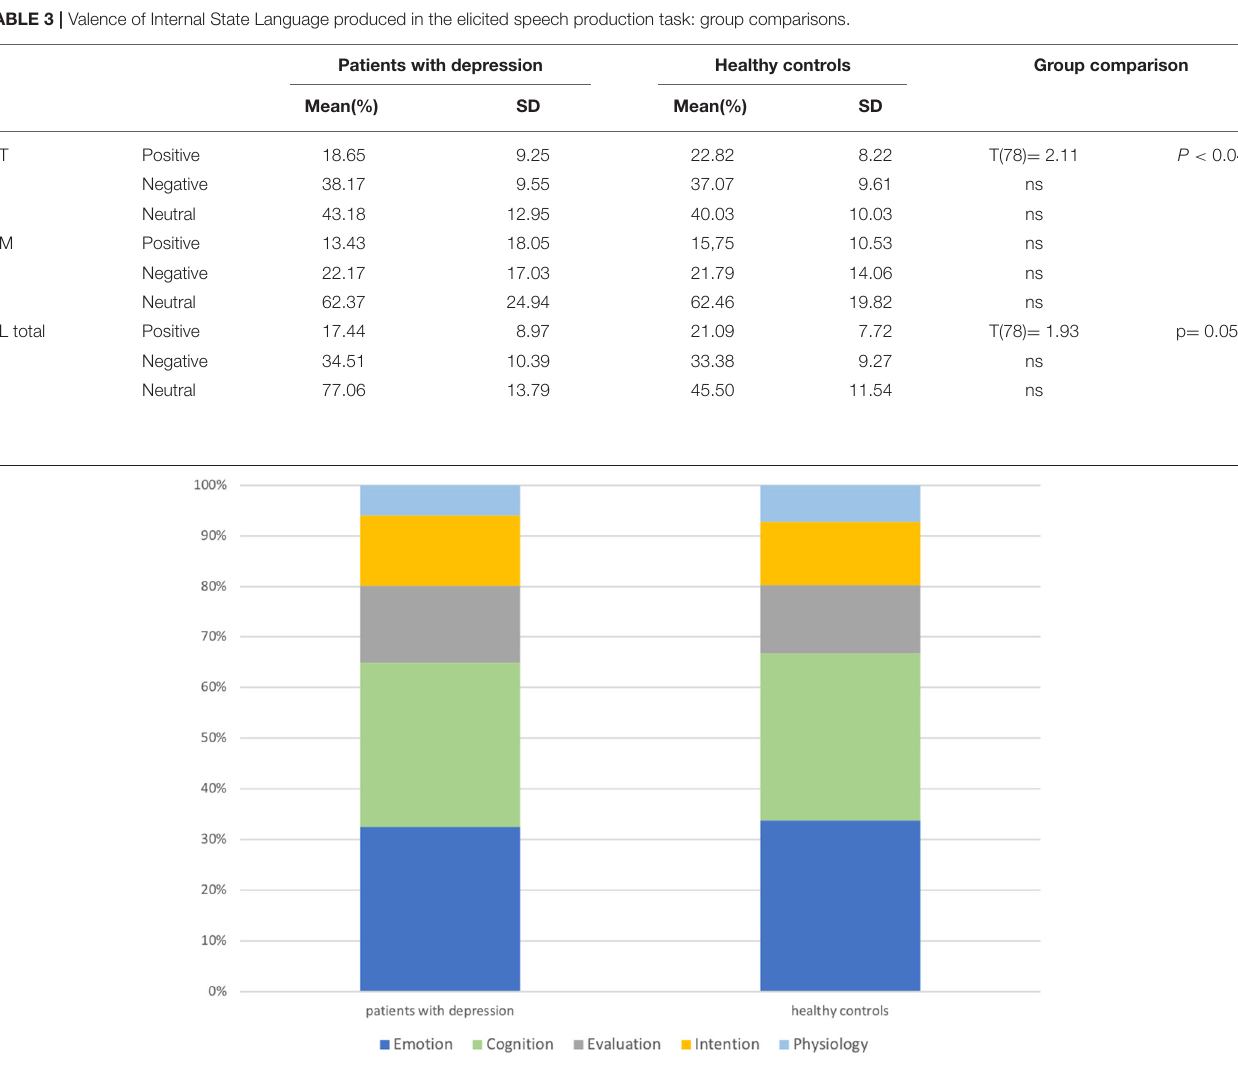
FIGURE 1 | Composition of produced IST in the elicited speech production task: group comparisons.